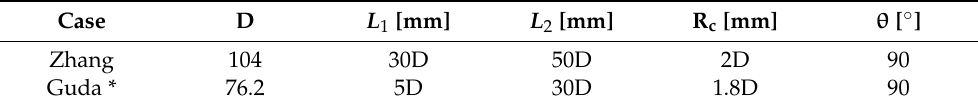
Table 2. Table 2. Fluid phase and dispersed phase